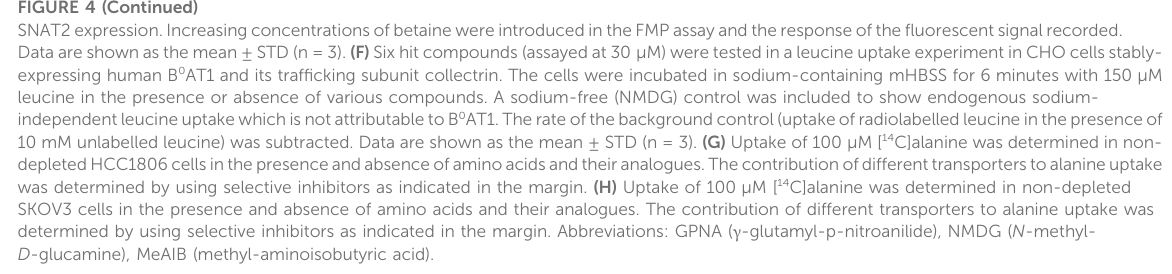
(Figure 5C) when analysing the betaine-sensitive fraction of proline uptake as a readout